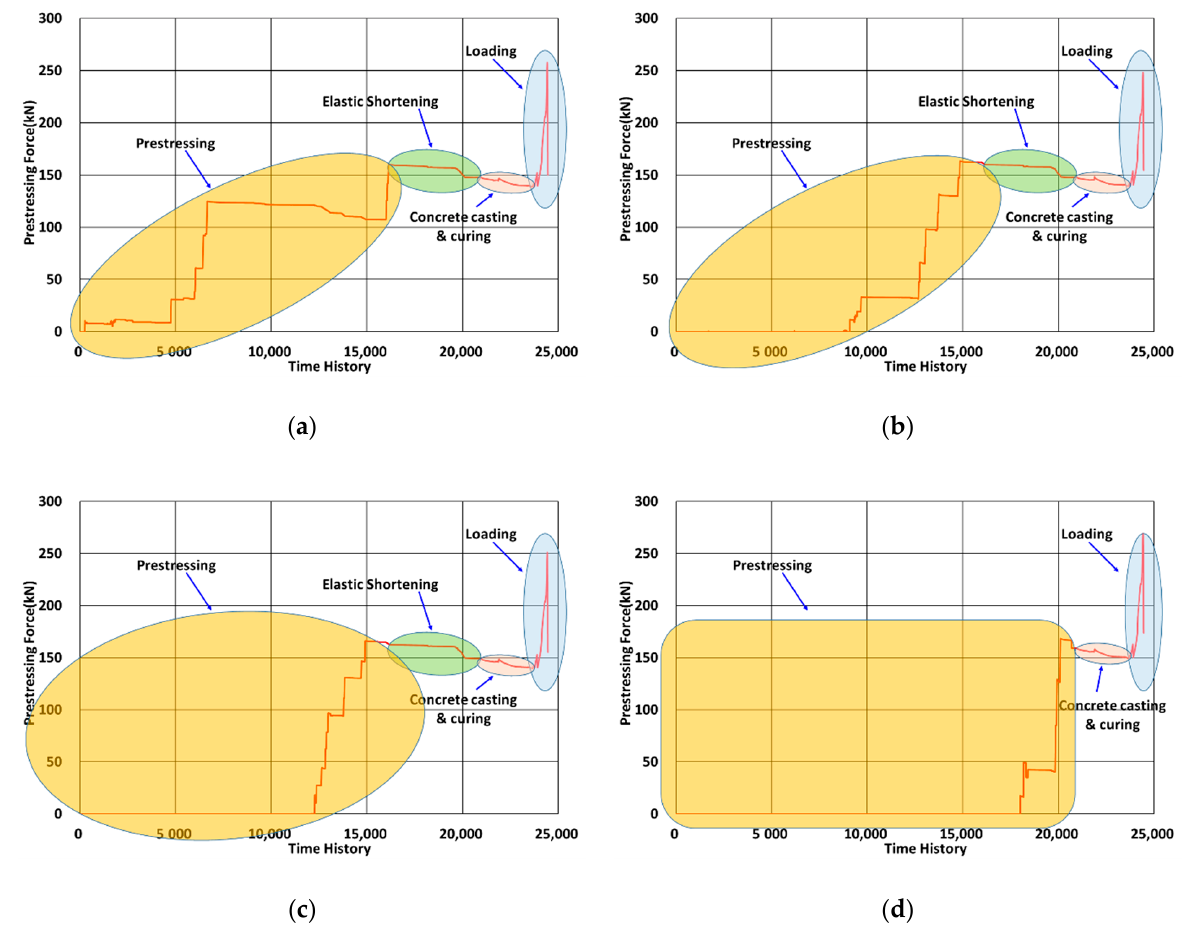
Figure 18. Change of prestressing force in BH girder bridge measured by OSPC strand: ( a ) Tendon one; ( b ) Tendon two; ( c ) Tendon three; ( d ) Tendon four.